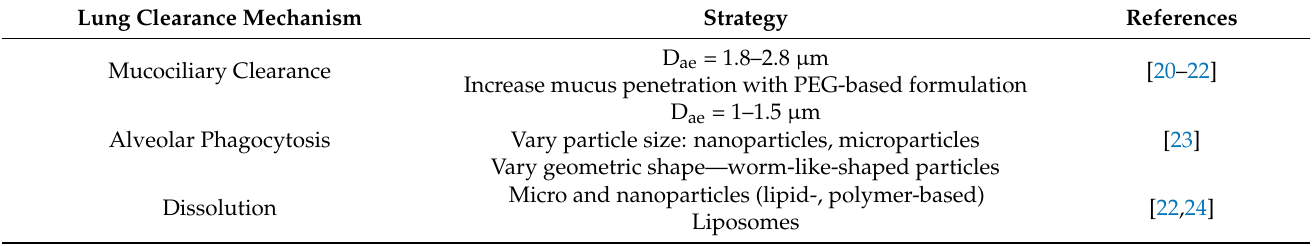
Figure 1. The clearance mechanisms involved at different sites in the lungs. Table 1. Formulation strategies to overcome removal of drugs via lung clearance mechanisms.